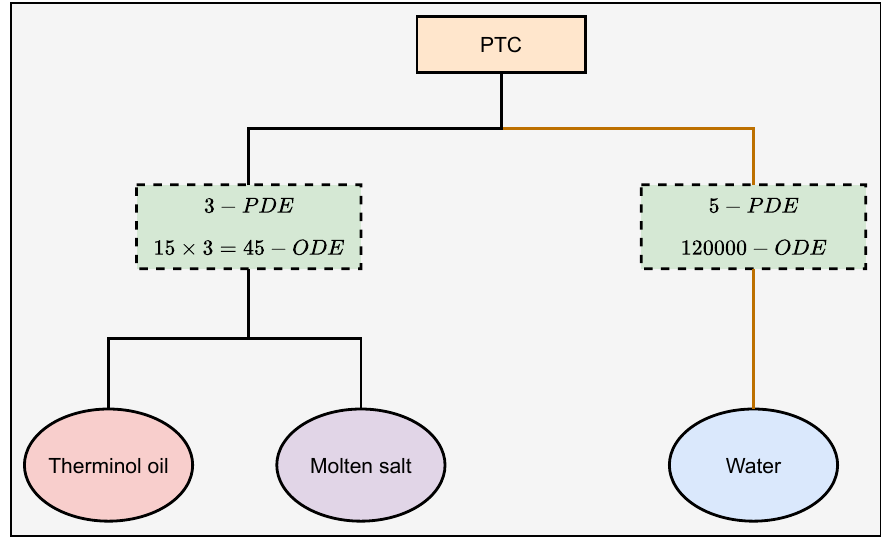
Figure 2. PTC with different HTF mathematical modeling